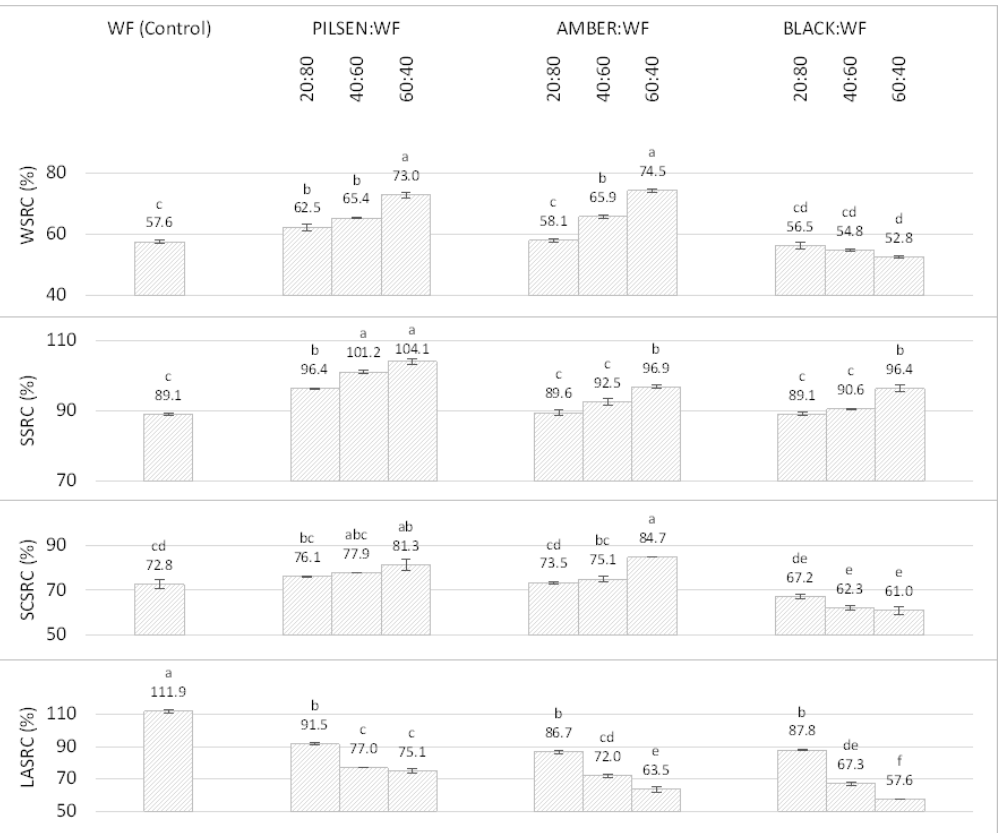
Figure 1. Solvent retention capacity (SRC) of malted barley and wheat composite flours. WSRC, SSRC, SCSRC, and LASRC denote water, sucrose, sodium carbonate, and lactic acid SRC, respectively. WF—Wheat flour. The values are Mean ± SD ( n = 3). Different letters (a–f) indicate statistically significant differences ( p < 0.05).